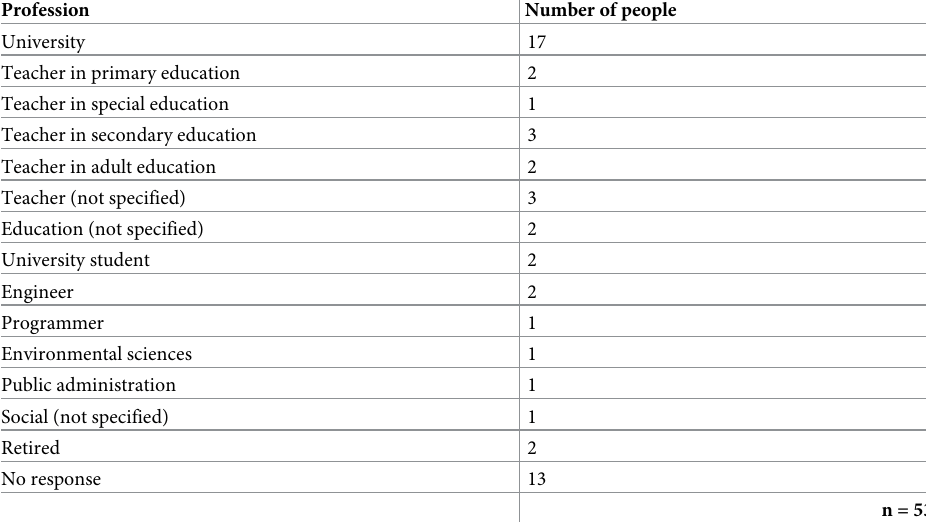
Table 4. Professional backgrounds of participants.